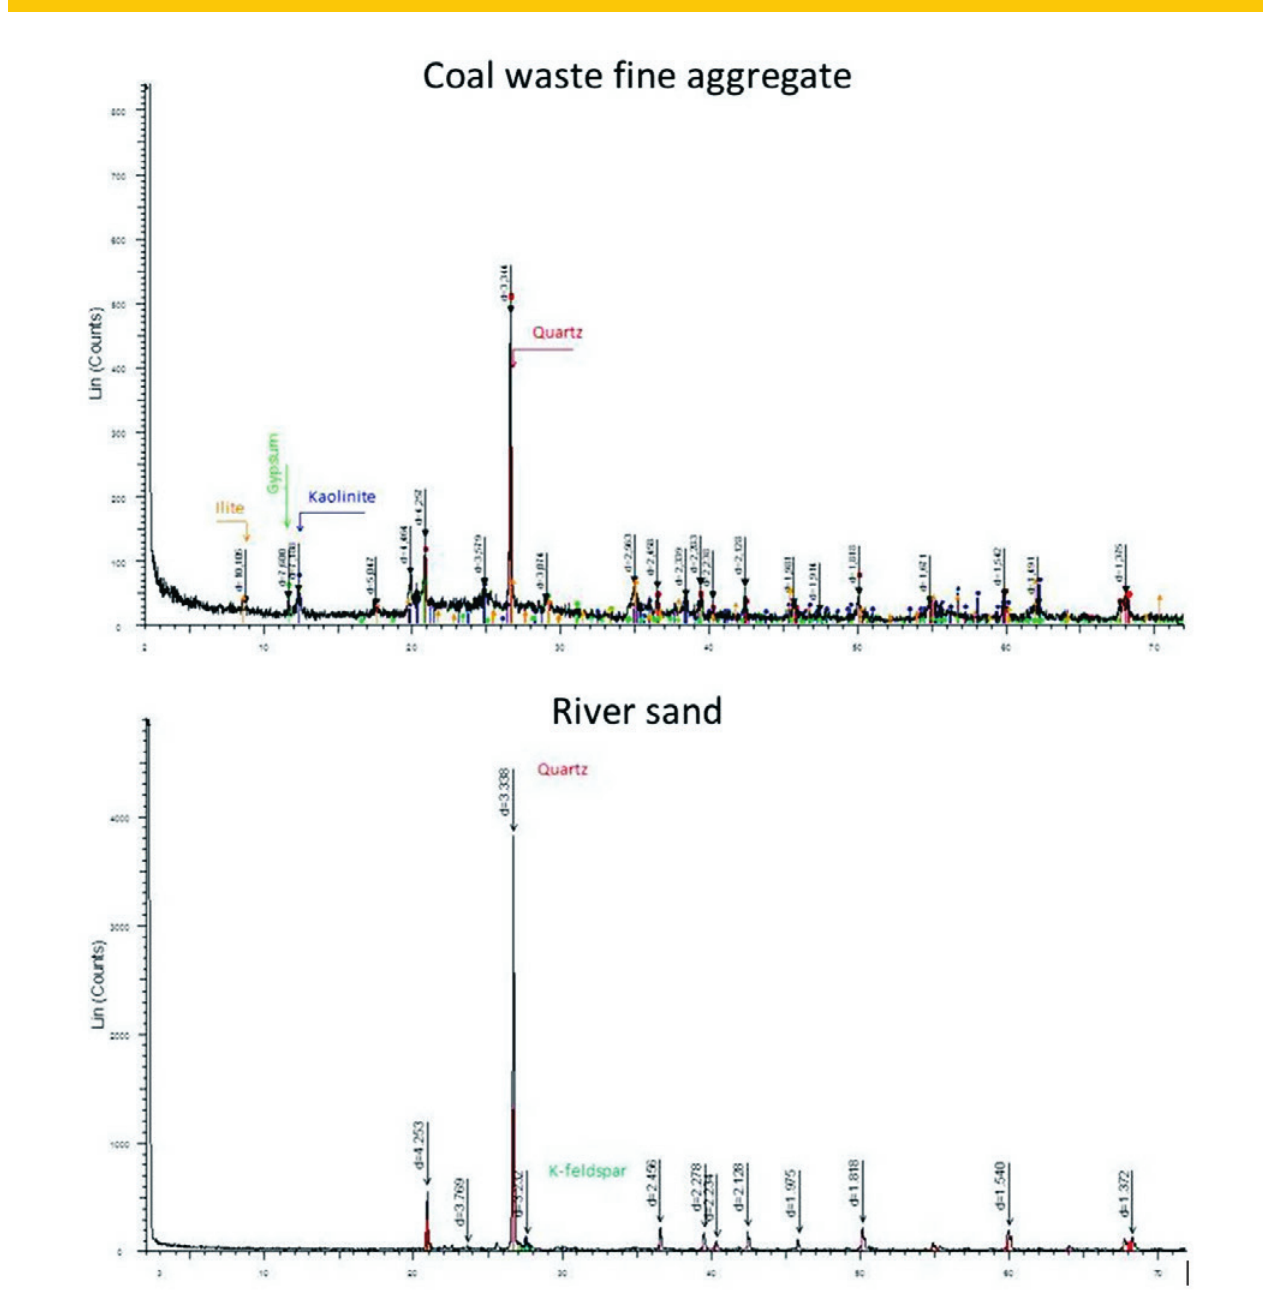
Figure 4 – X-ray diffraction patterns of coal waste fine aggregate and river